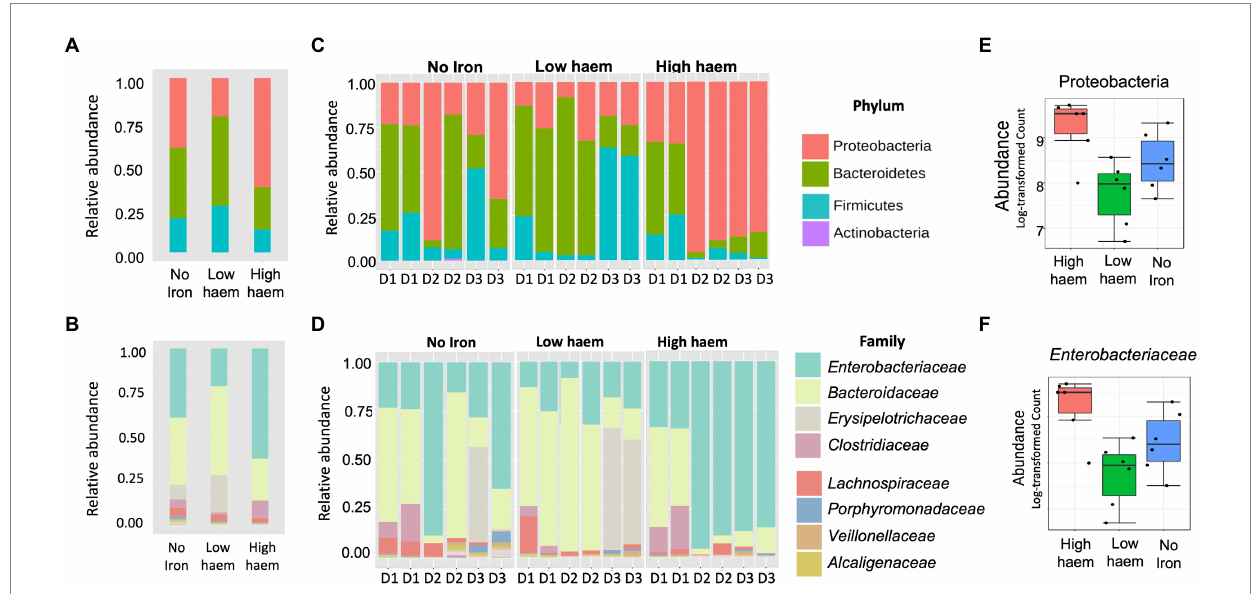
FIGURE 6 Impact of haem and inorganic iron on gut microbiota composition. Average (A, B) and individual (C, D) relative abundances of microbiota composition in response to haem addition (0, low 7.7 μ M or high 77 μ M) at phylum (A, C) and family levels (B, D) at 36 h. D1, D2, and D3 in figures (C) and (D) refer to the faecal donors. Relative abundance of taxa showing significant ( p < 0.05) change in response to haem regime for the Proteobacteria phylum (E) and the family Enterobacteriaceae (F) are